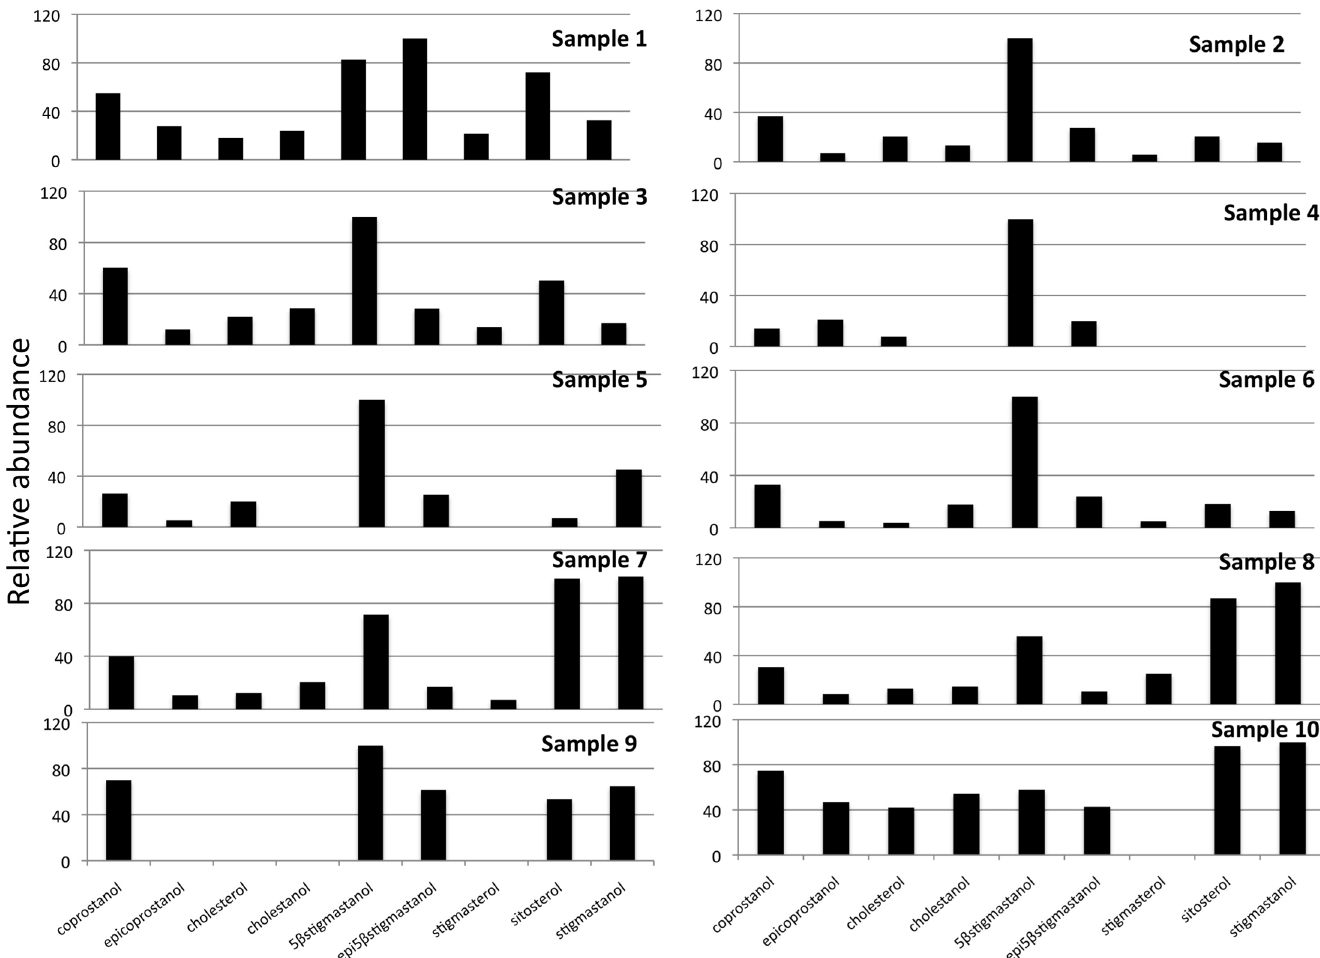
Fig 1. Sterol fraction histogram from the chimpanzee samples. Relative concentrations are expressed as % of the largest peak compared to TIC (total ion chromatogram) in the chromatogram.